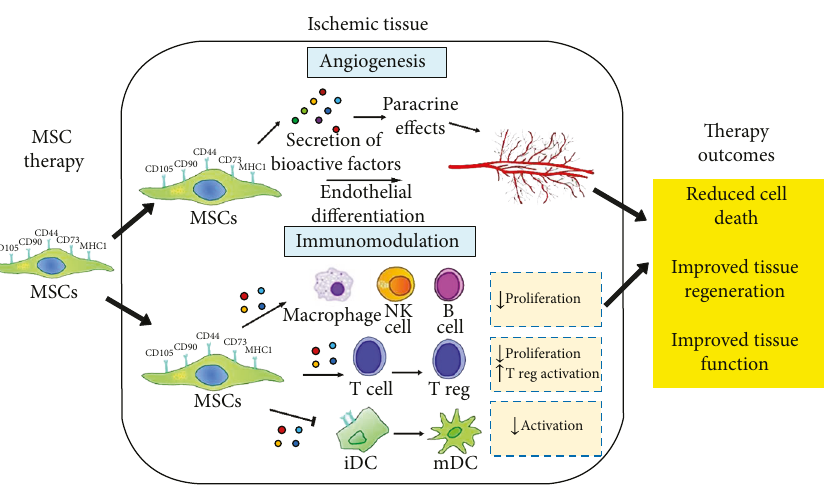
Figure 1: Main mechanisms of human mesenchymal stem cells (hMSCs) in the treatment of ischemic tissue. hMSCs repair ischemic tissues and restore the tissue function via angiogenesis and immunomodulation. NK: natural killer; reg: regulatory; iDC: immature dendritic cell; mDC: mature dendritic cell. This image is adapted from [12] published under the Creative Common Attribution